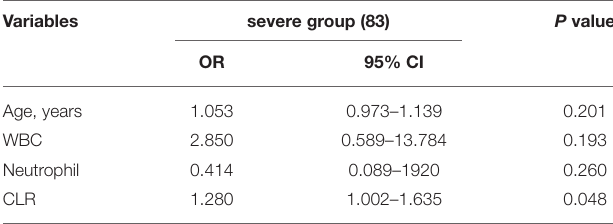
TABLE 5 | Multivariable logistic regression analysis of poor clinical prognosis in severe group (Hunt-Hess >